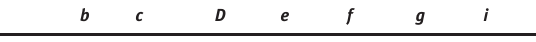
Table 14: Fit results of f 2 ð _ ε , T Þ of BR1500HS steel. a